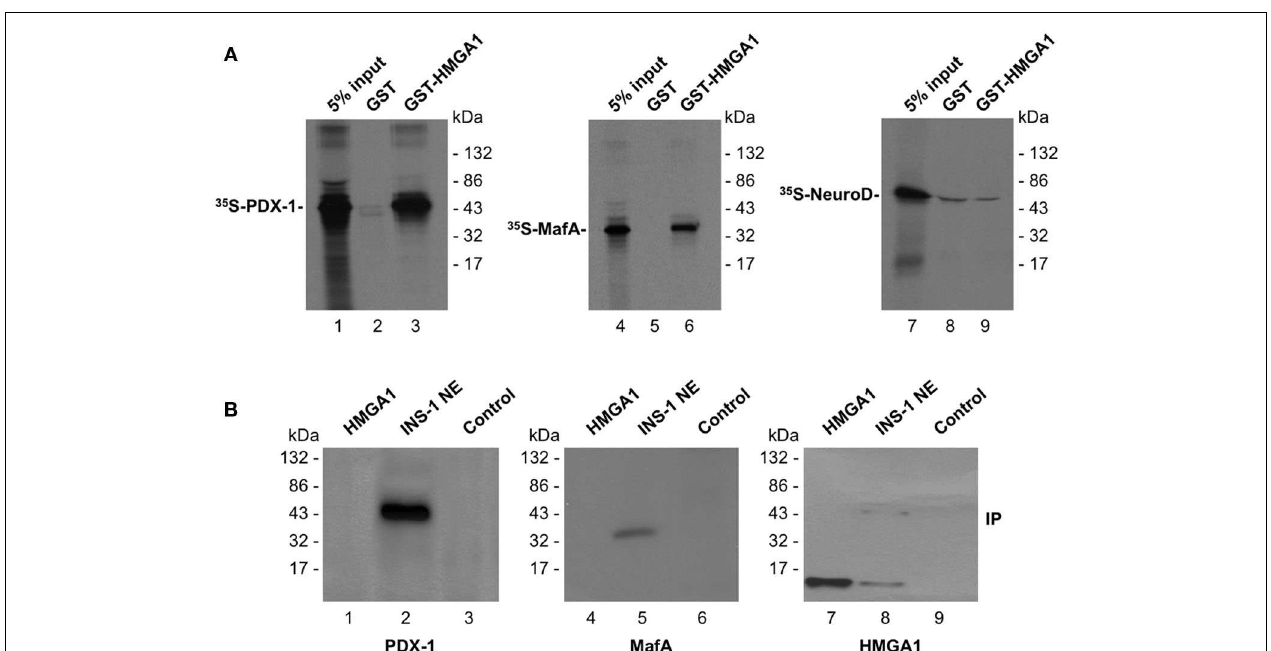
antibody (lanes 7–9) after reprobing the same transfer. Lanes: 1, 4, and 7, 10ng of pure HMGA1, 2, 5, and 8, INS-1 nuclear extract (NE; 500 µ g). In lanes 1, 4, and 7, protein was directly applied to the gel without binding to and elution from protein A beads.To prove specificity, pure Sp1 (15ng) was used for immunoprecipitation by the anti-HMGA1 antibody (lanes 3, 6, and 9, control).The faint band in lane 8 at 43kDa represents non-specific signal. A representative of three separate assays is shown for each